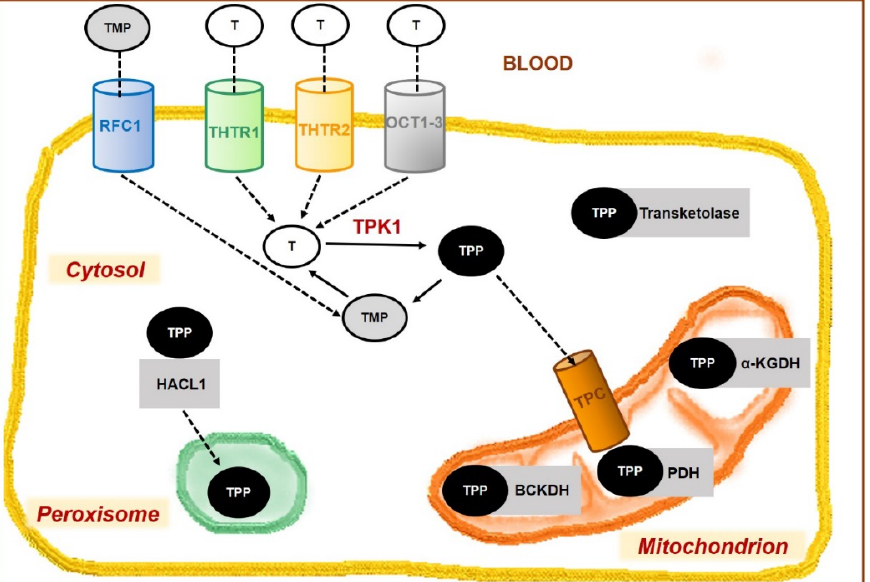
Figure 3. Cellular uptake of thiamine. THTR1 carrier (encoded by SLC19A2 gene); THTR2 carrier (encoded by SLC19A3 gene); OCT1-3, organic cation-transporters 1–3; RFC-1, reduced folate carrier (encoded by SLC19A1 gene); TPC, thiamine pyrophosphate carrier (encoded by SLC25A19 gene); T, thiamine; TPP, thiamine pyrophosphate; TMP, thiamine monophosphate; TPK1, thiamine phosphokinase; BCKDH, branched-chain α -ketoacid dehydrogenase; PDH, pyruvate dehydrogenase; α -KGDH, α -ketoglutarate dehydrogenase; HACL1, 2-hydroxyacyl-CoA lyase 1. Within the cell, free thiamine is phosphorylated to thiamine pyrophosphate (TPP) by a specific cytosolic kinase, i.e., thiamine pyrophosphokinase (TPK1). The synthesis